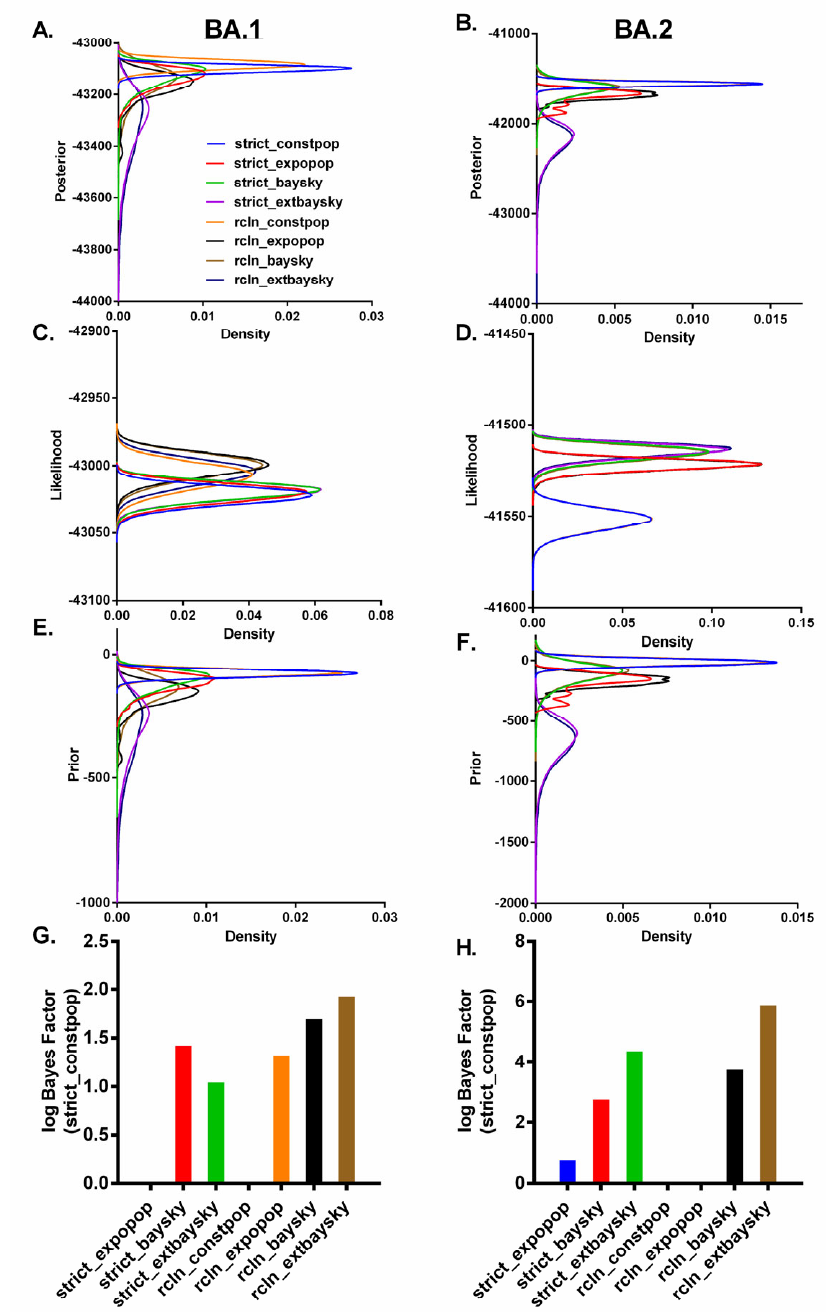
Figure 4. Bayesian hypothesis testing using the log Bayes factor. Posterior ( A , B ), Likelihood ( C , D ) and Prior ( E , F ) estimates for comparative evaluation of eight combinations of tree priors and clock models implemented in BEAST v2.6.7 are shown for the BA.1 and BA.2 sub-lineages, respectively. ( G , H ) Bayesian hypothesis testing using the log Bayes factor. The best fit combination of tree priors and clock models was the constant population coalescent tree prior with strict clock for both the Omicron sub-lineages, BA.1 and BA.2.